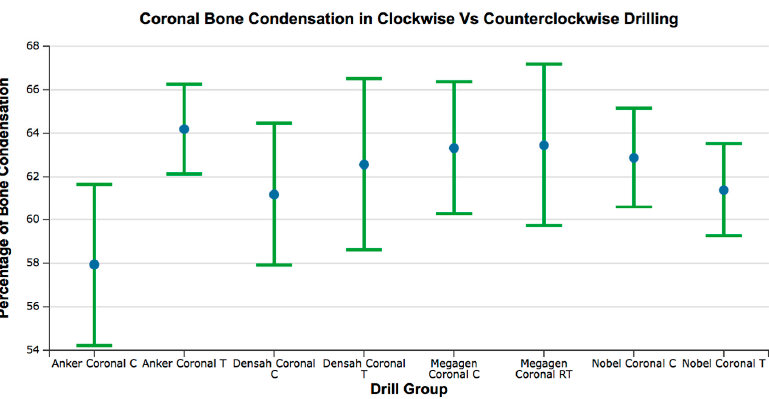
Figure 7. Box plot for the percentage of bone condensation at the coronal area for all groups. C = clockwise drilling; T = counterclockwise drilling. The Anker drill group showed a lower mean value; however, the statistical analysis did not show significant differences. Table 3. Statistical comparison of the relative bone condensation at the coronal region for all of Table 2. Descriptive statistics. Relative bone condensation at the coronal region. the groups. No significant differences were observed between groups. T = Test, C = Control, SE = Standard Error, t = test, p = p value.